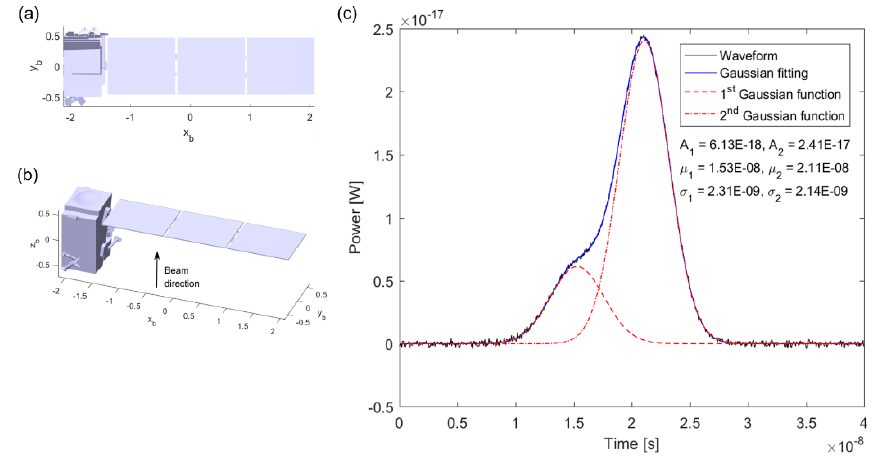
Figure 5. The ( a ) reflected surface, ( b ) orientation of defunct satellite, and ( c ) the echo waveform and 2 Gaussian functions obtained from the Gaussian decomposition, for no rotation w.r.t. Figure